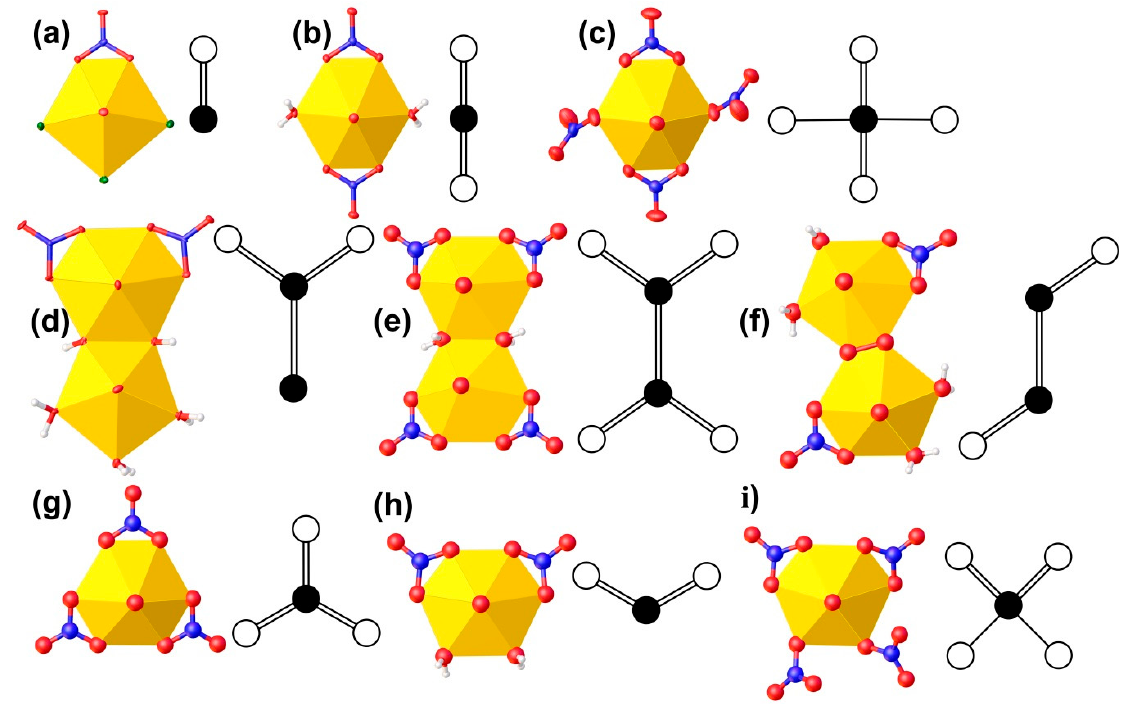
Figure 2. Finite clusters and their respective topologies that were described in the crystal structures of uranyl nitrate compounds, including those found in the structures of 1 – 3 ( a ), 4 ( b ), 5 ( c ), and 6 ( d ). Finite clusters shown in ( e – i ) are drawn according to the literature data (see text for details). Legend: U-bearing coordination polyhedra = yellow; O atoms = red; N atoms = blue; Cl atoms = green; H atoms = light grey; black nodes = U atoms, white nodes = N atoms.